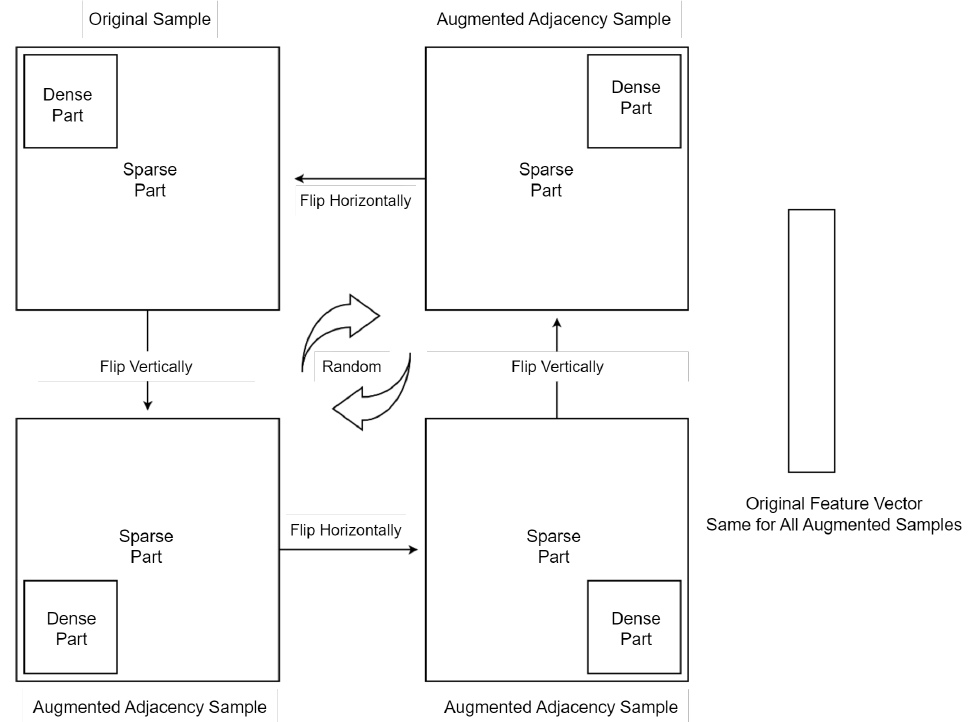
Figure 12. For each adjacency matrix in the training set, the dense part is flipped systematically and the original feature vector is fixed for all augmented samples. Then we extend the training dataset with the new augmented adjacency matrix concatenated with the original feature vector as follows [Adj Augmented | X